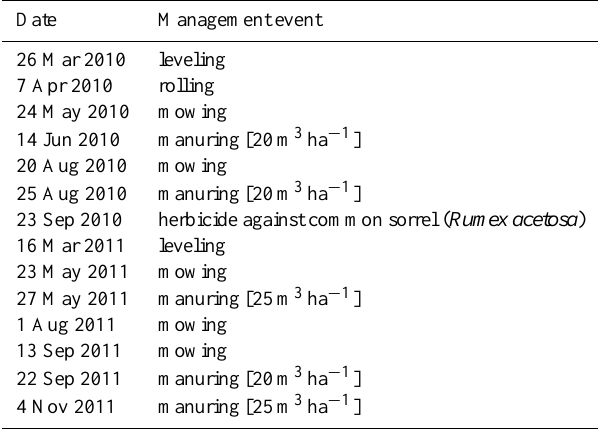
Table 1. Summary of the grassland management for both vegetation